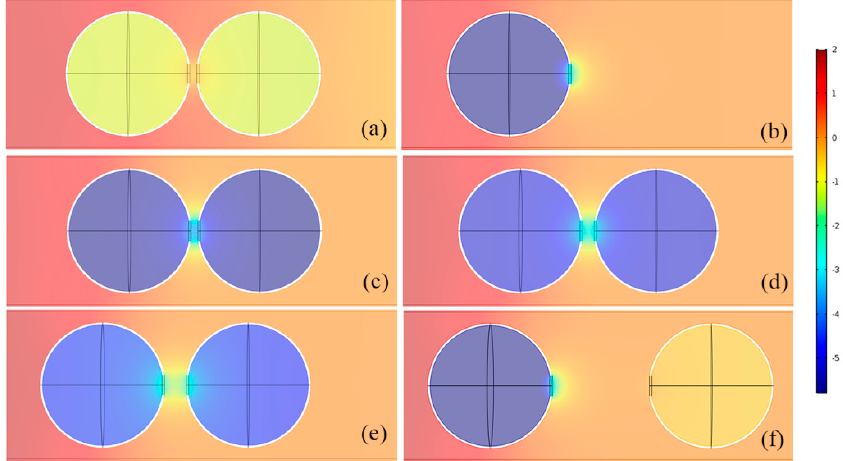
Figure 6. The acoustic field distribution at 1150 Hz of ( a ) DSSHS and ( b ) SHS. The transmitted acoustic field of DSSHS with different hole distances at resonant frequency, ( c ) 1, ( d ) 2, ( e ) 4, and ( f ) 19 mm.